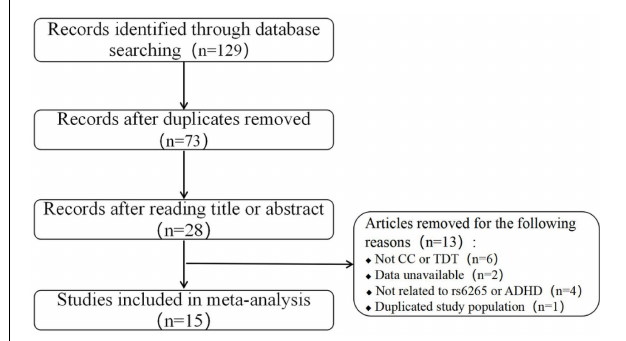
FIGURE 1 | Flow diagram of the study selection used in this meta-analysis.